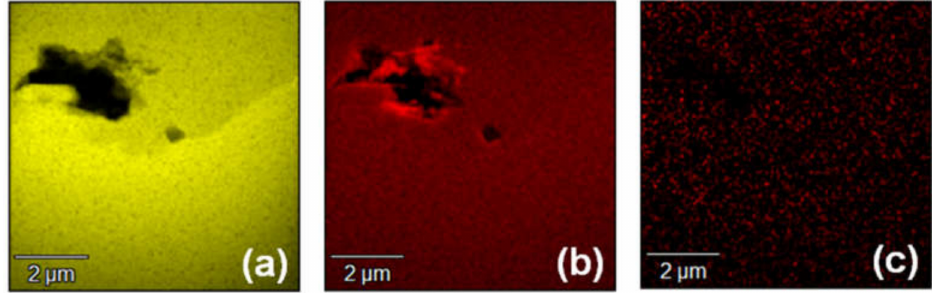
Figure 9. Cross-sectional ( a ) SEM and ( b ) bright-field TEM images around the origination of the 3C-inclusion in the on-axis 4H-SiC epitaxial layer at the growth rate and ramp-up time of 40 µ m / h and 60 min.